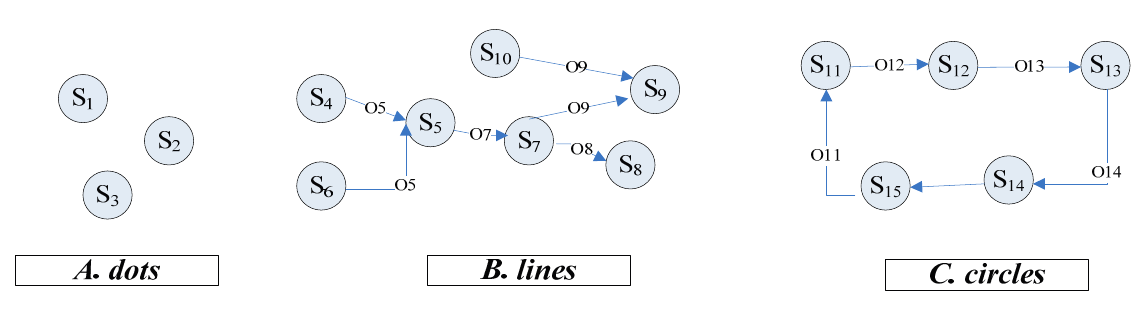
Figure 9. The typical forms of sensor